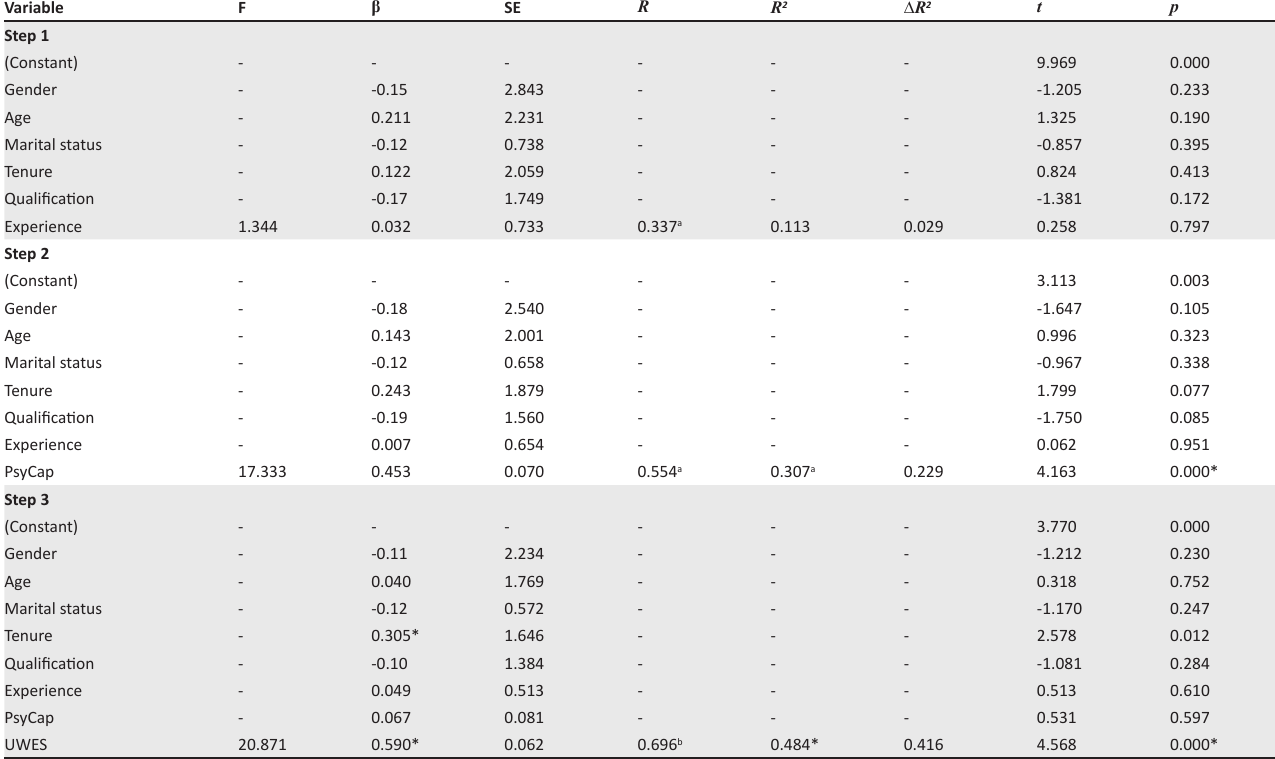
TABLE 4: Hierarchical regression to determine the predictive value of the independent variables (PsyCap and UWES) on the dependent variable (Organisational commitment).